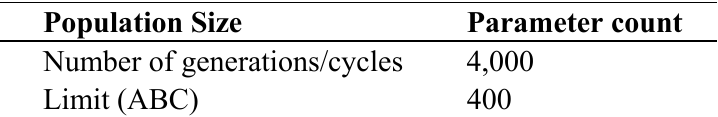
Table 3. Control parameters of ABC.